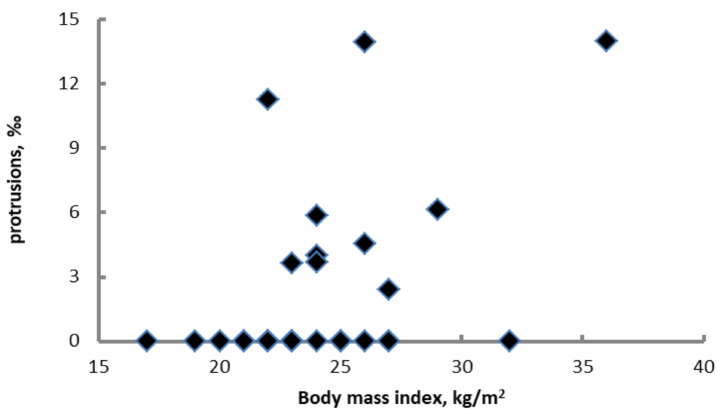
Figure 1. Positive association between the frequency of nuclear protrusions ( index in miners under the age of 30 years (kg/m 2